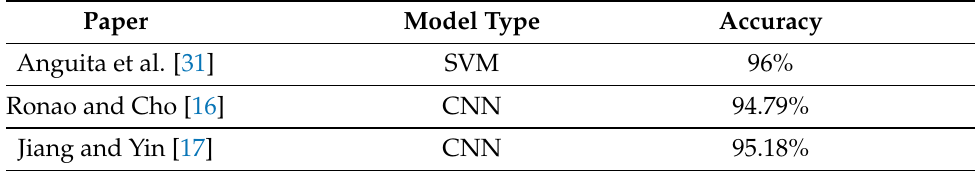
Table 13. Performances of a set of models of related work on the UCI HAR dataset.